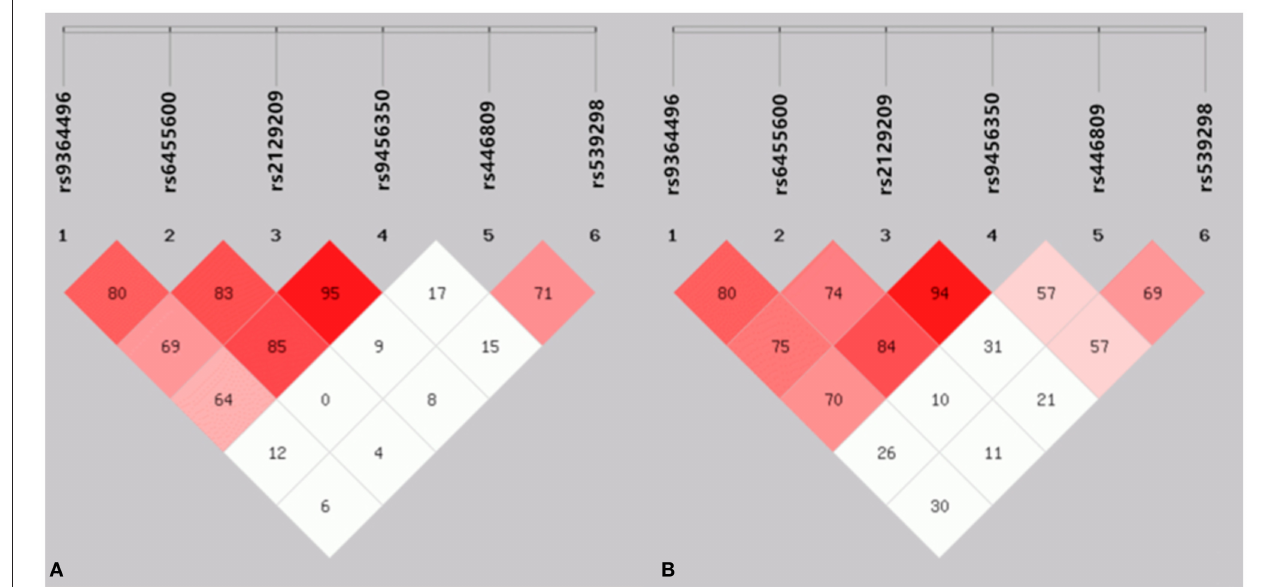
FIGURE 2 | The linkage disequilibrium (LD) represents pair wise D ’ × 100 in the CAD (A) and IS (B) groups.